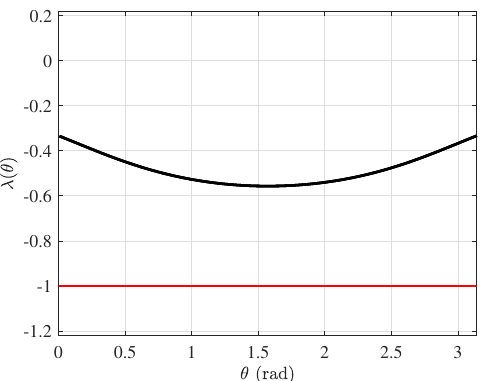
Figure 11. The eigenvalue λ ( θ ) as the phase angle is varied within ( 0, π ) with an adaptive compen- R s m 0 sation scheme using m r = −